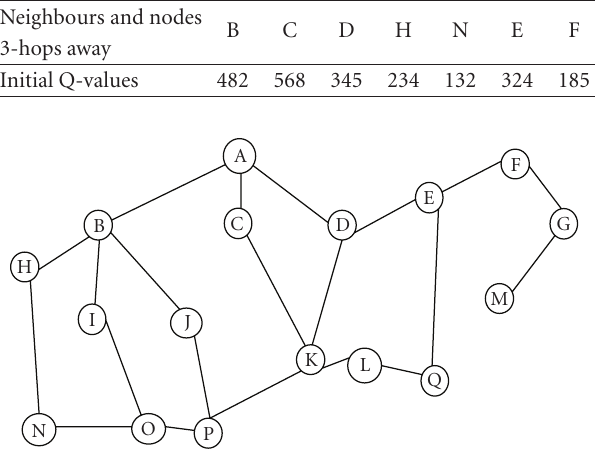
Figure 4: An Unstructured P2P